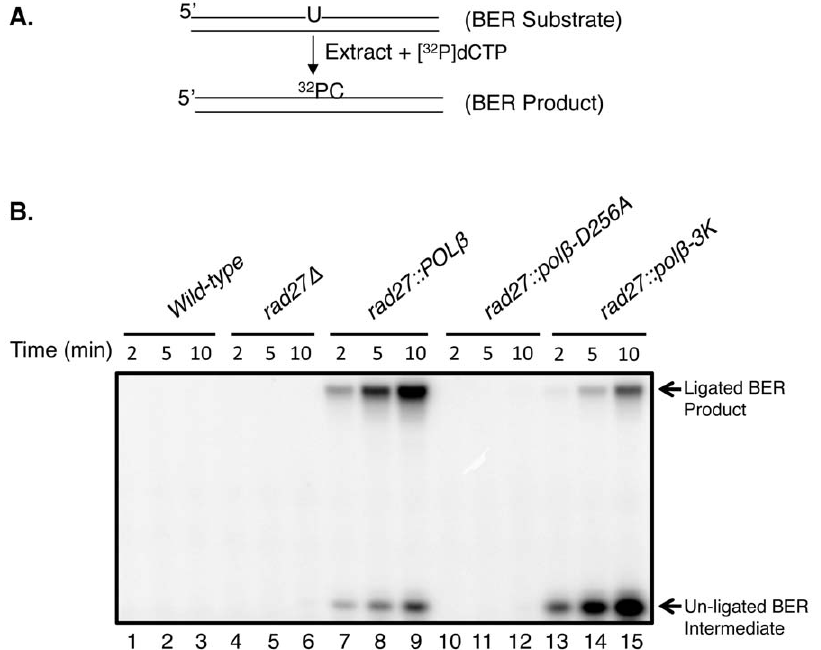
Figure 3. Invitro BER capacity of S.cerevisiae extracts. (A) Schematic representations of the substrate and the reaction scheme are shown. (B) Repair reactions (15 m l each) were incubated either with extracts from wild-type (lanes 1–3), rad27 D (lanes 4–6), rad27::POL b (lanes 7–9), rad27::pol b - D256A (lanes 10–12), or rad27::pol b -3K (lane13–15), respectively. Note that all the reaction mixtures were supplemented with human DNA ligase I (200 nM). Aliquots (4.5 m l each) were withdrawn at 2, 5 and 10 min. The repair reaction was terminated by addition of an equal volume of DNA gel- loading buffer. After incubation at 75 u C for 2 min, the reaction products were separated by electrophoresis in a 16% polyacrylamide gel containing 8 M urea. A Typhoon PhosphorImager was used for gel scanning and imaging. The positions of ligated BER product and un-ligated BER intermediate are indicated.